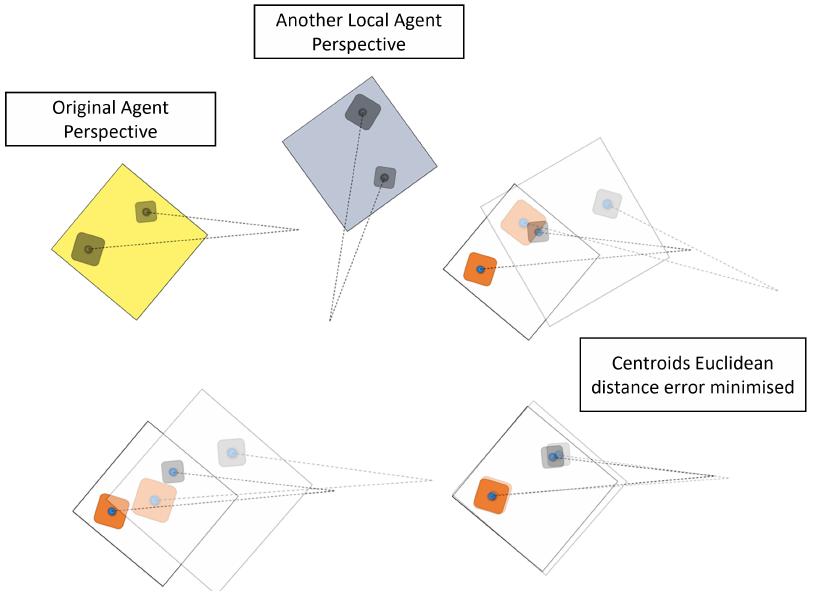
Figure 20. Figure objects being used for global alignment of the